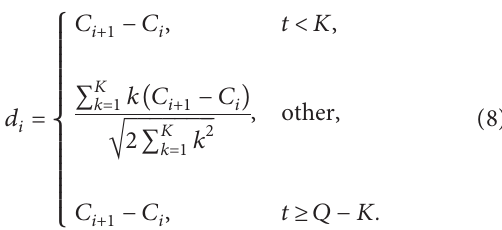
Figure 2: Differential parameter Delta MFCC extraction